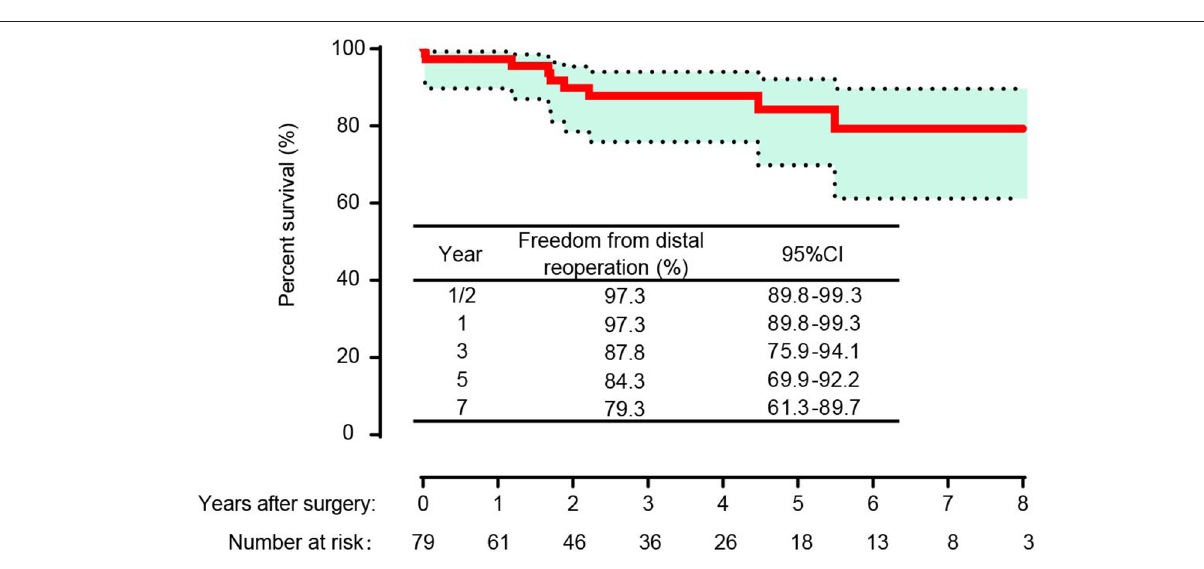
and 64% for survival without distal aortic reoperation ( Figure 5